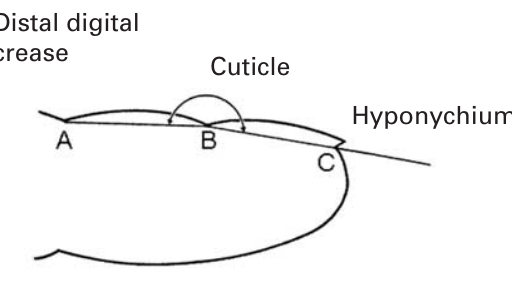
Distal digital crease